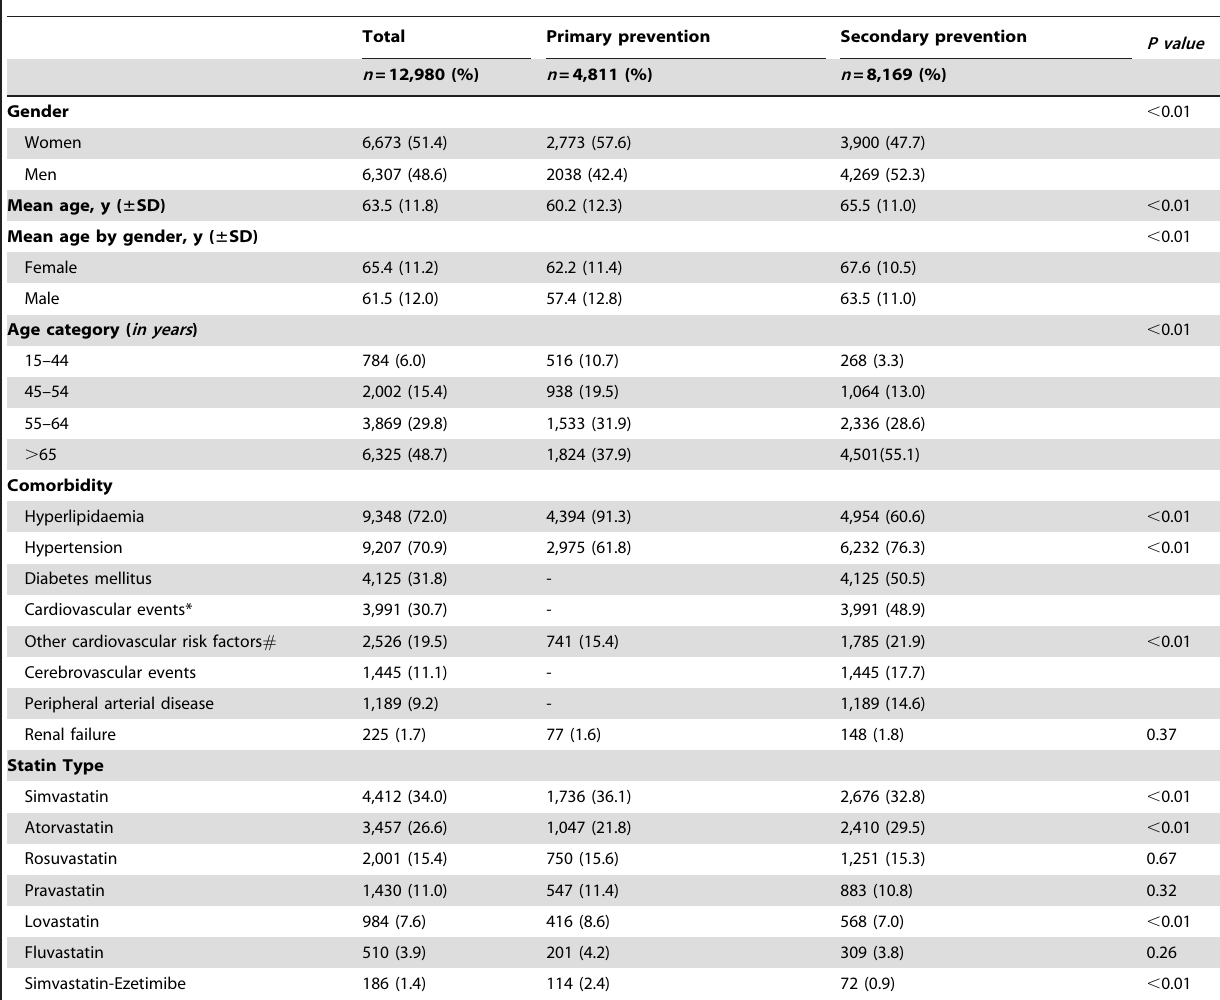
Table 1. Baseline characteristics of new users of statins by type of